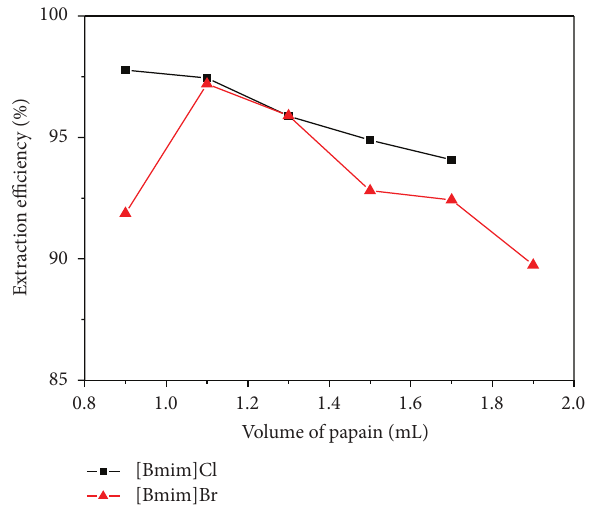
Figure 5: Effect of volume of protein on the partition coefficients in the ILs+K 2 HPO 4 aqueous two-phase systems (0.8 g K 2 HPO 4 +0.6g ILs + 1.3 mL H 2 O).